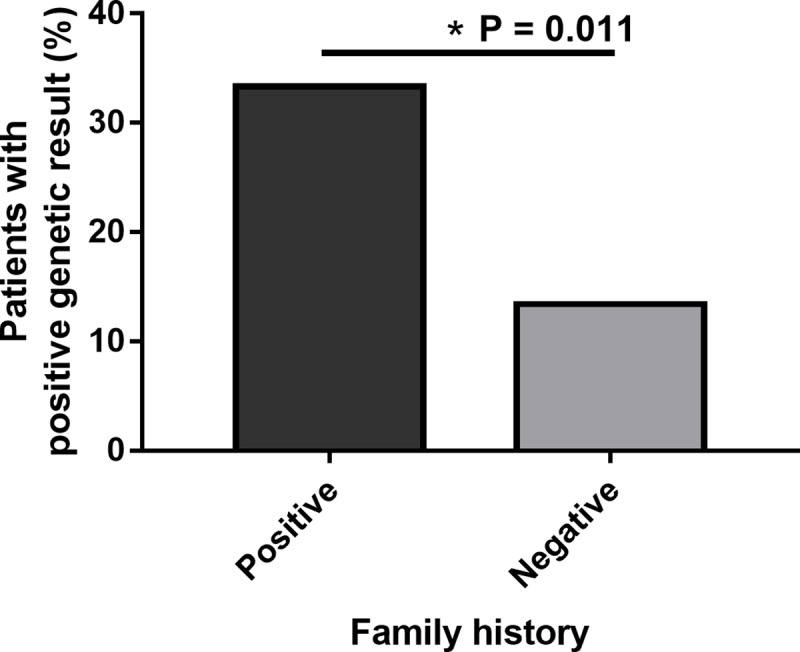
Positive predictive value of a genetic test result in patients with a positive or negative family history of optic atrophy.Of those that reported a positive family history, 10/30 (33.3%) patients had a positive genetic test result. Of those with a negative family history, 9/67 (13.4%) had a positive genetic test result (OR, 1.20–9.02; *, p = 0.011; CI = 95%).